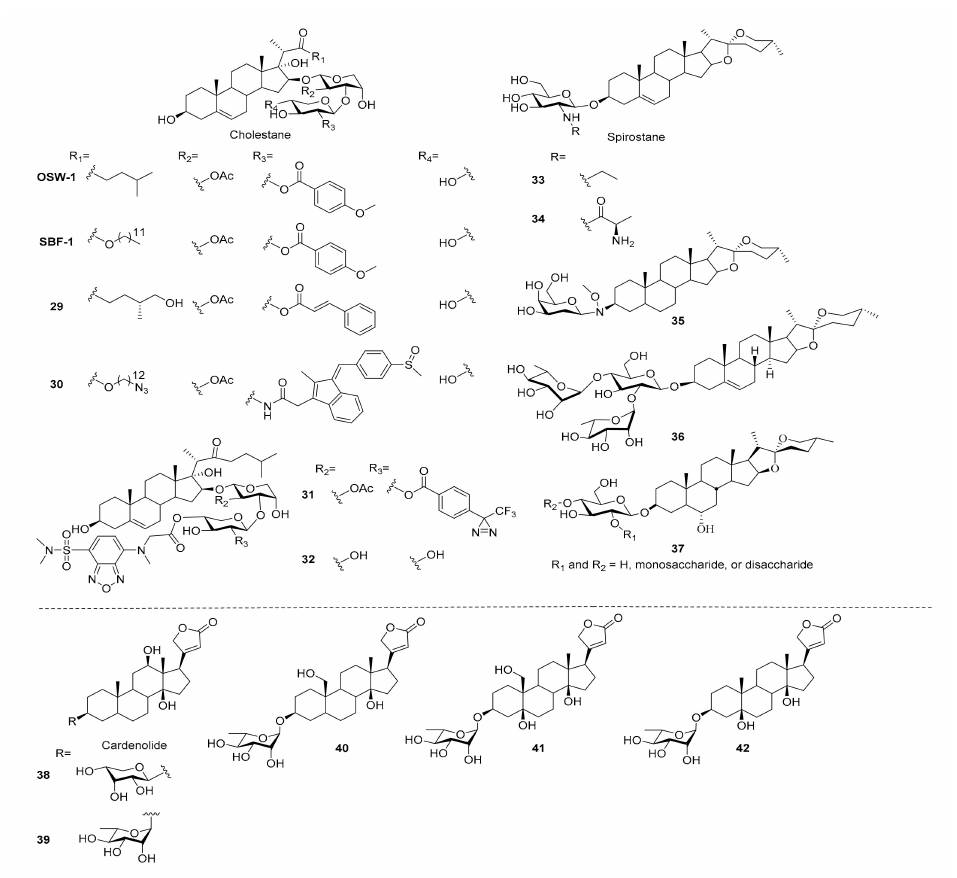
Figure 5. Synthetic saponins derived from steroid-type